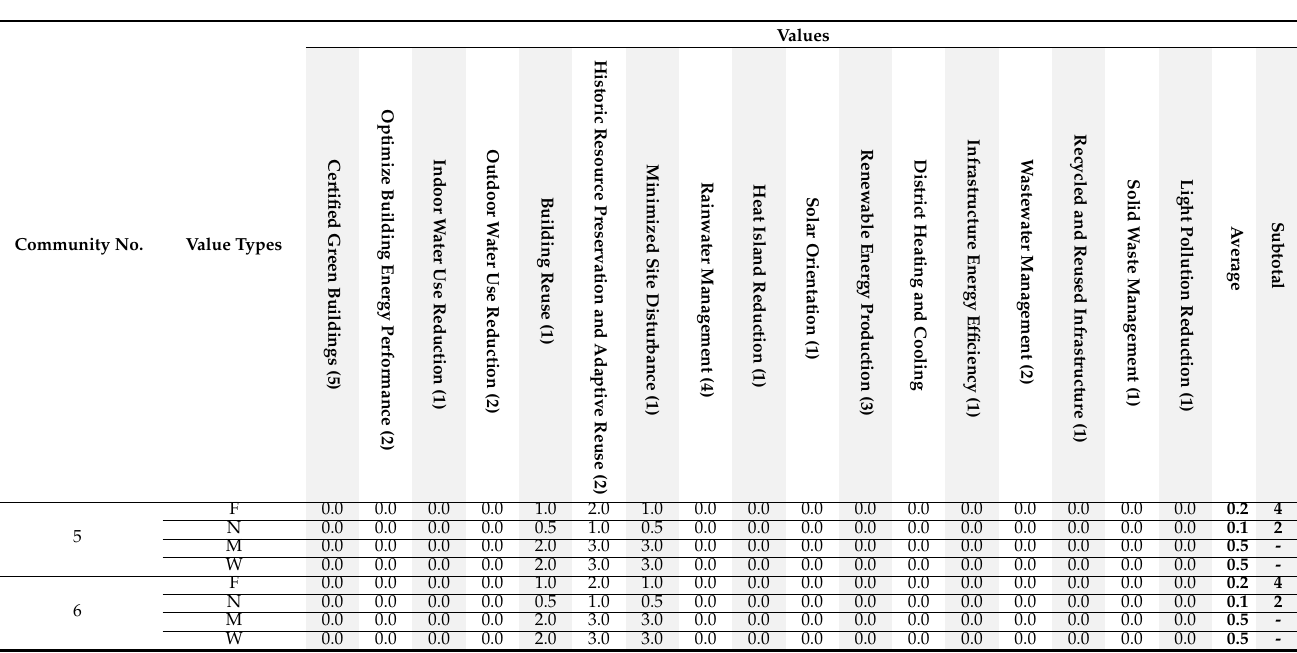
Table 5. Concordance between LEED-ND and parametric Form-Based Code.